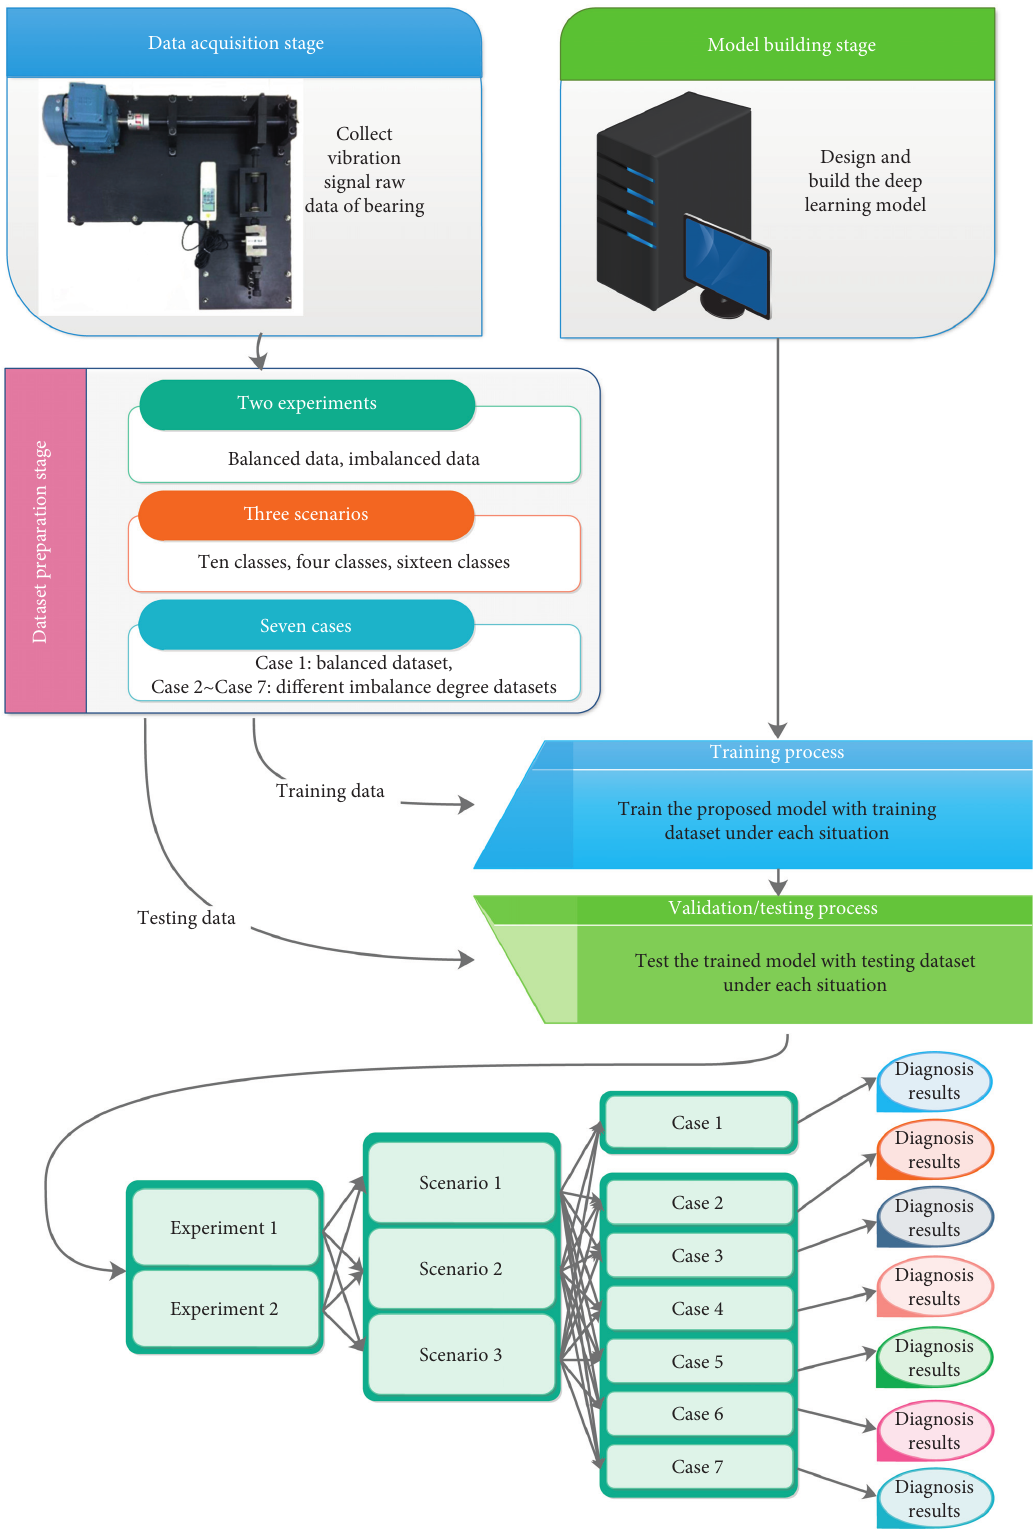
Figure 3: Flowchart of